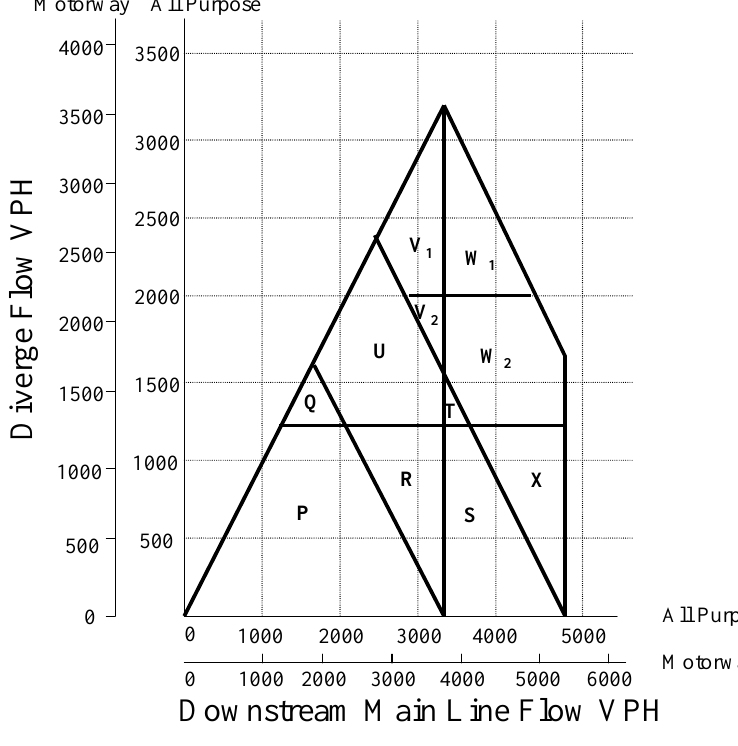
Figure 5. Diverging flow-region diagram from H18/75 (motorway scale added from TD22/86) Table 4. Diverging lane types applicable to flow-regions in Figure 5 Diverging lane